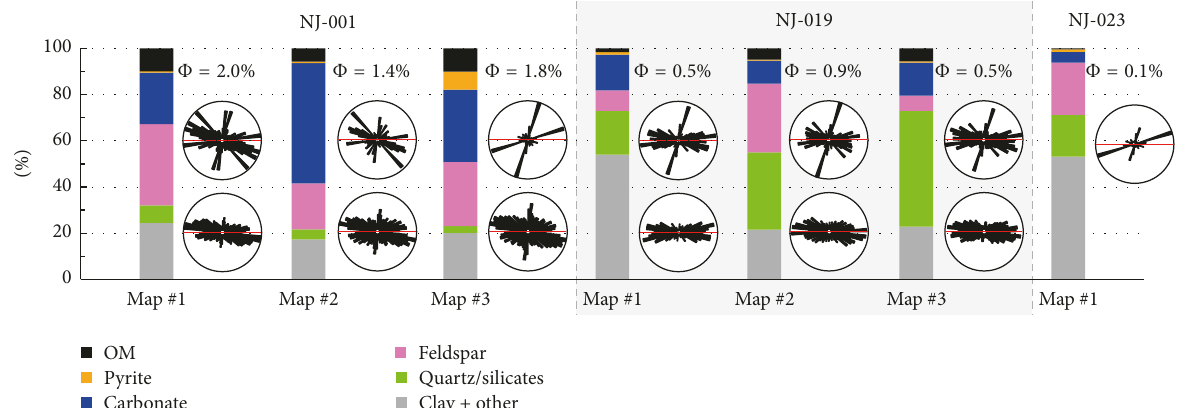
Figure 9: Summary of BIB-SEM investigation results showing EDX mineral compositions (bars) and visible porosities as well as pore orientations of all pores (top), respectively, excluding microcracks and pores below the PPR (bottom) of each mosaic